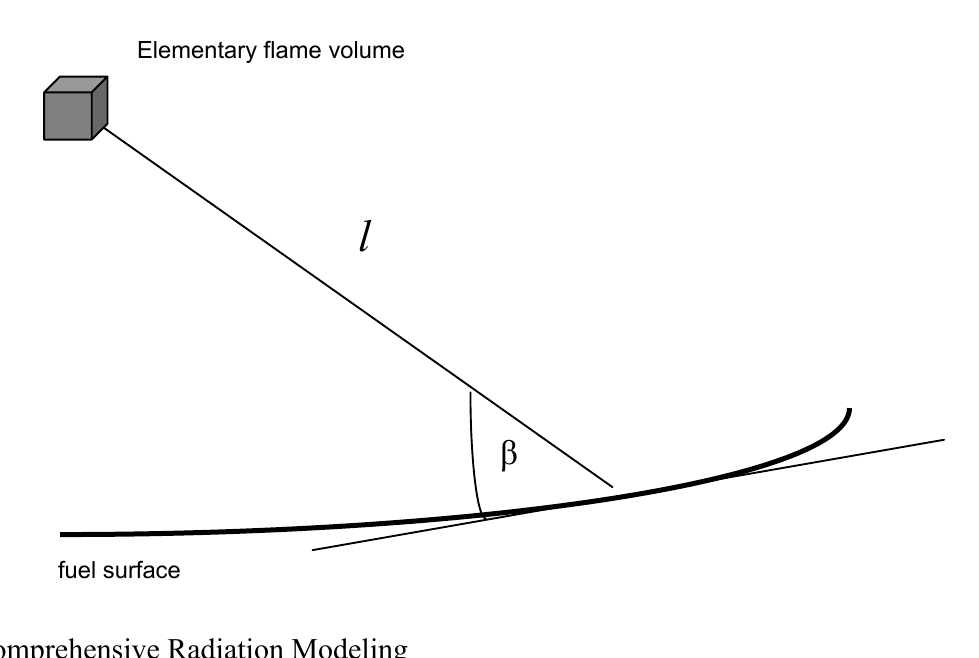
Figure 11. Calculation of incident radiative